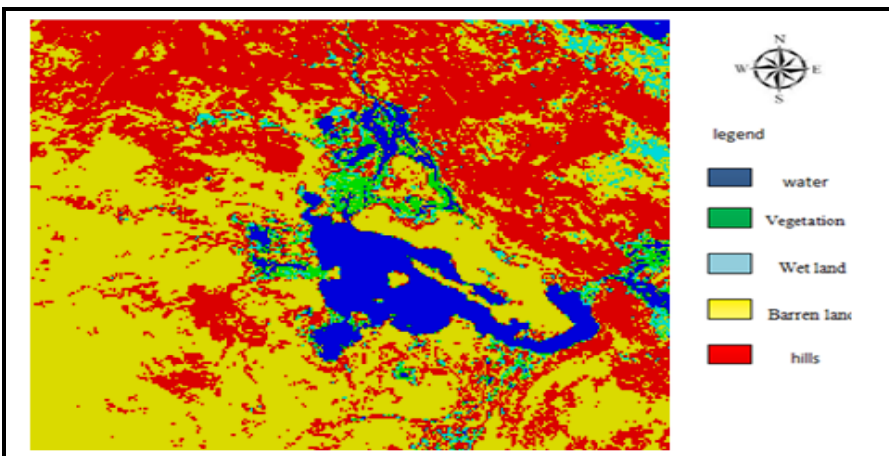
Fig.6: Unsupervised classification using mean value for Landsat-8